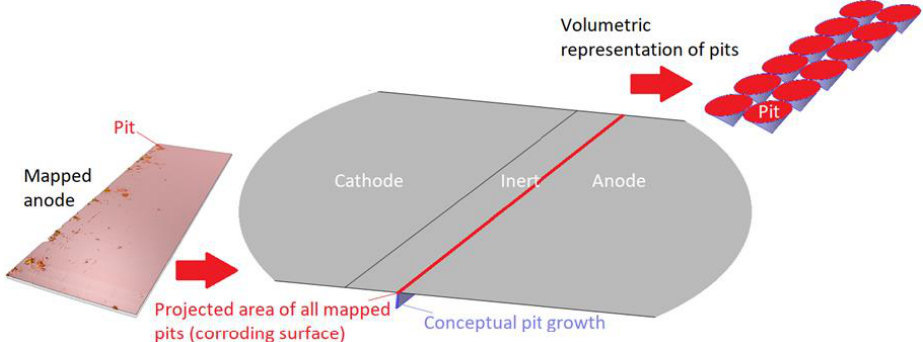
Figure 4. Description of the 1D corroding surface used in the model.